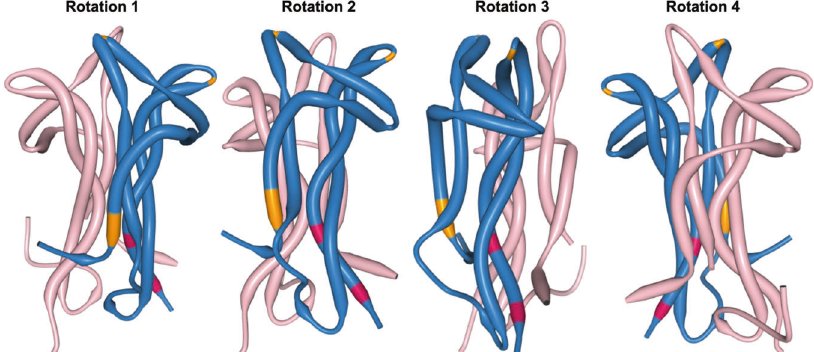
Fig. 3 BDNF NT-4 heterodimer structural analysis to highlight coevolving and adaptive sites at the 3D protein level. Demonstrating the structural con fi guration of the BDNF (blue) and NT-4 (pink) heterodimer (see https://www.rcsb.org/structure/1B8M), with rotations